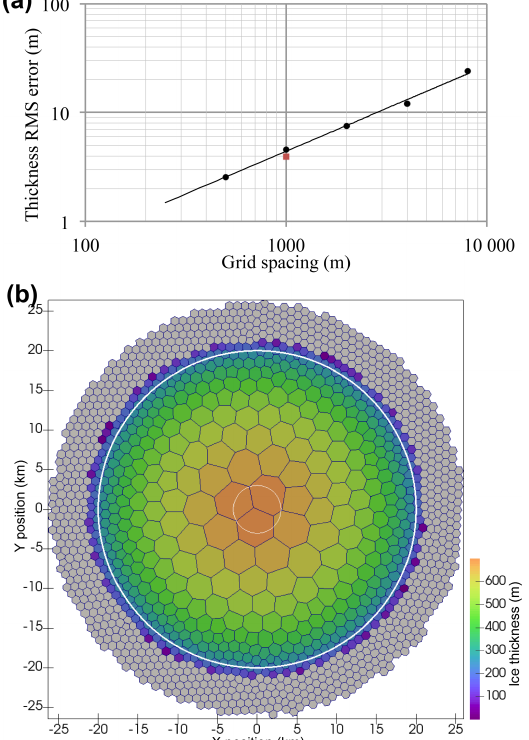
Figure 6. (a) Root mean square error in ice thickness as a function of grid cell spacing for the Halfar dome after 200 years shown with black dots. The order of convergence is 0.78. The red square shows the RMS thickness error for the variable-resolution mesh shown in (b) with 1000m spacing around the margin. (b) Mesh with resolu- tion that varies linearly from 1000m grid spacing beyond a radius of 20km (thick white line) to 5000m at a radius of 3km (thin white line). The ice thickness initial condition for the Halfar problem is shown. This mesh requires 1265 cells for the 200-year duration Halfar test case, while a uniform 1000m resolution mesh requires 2323